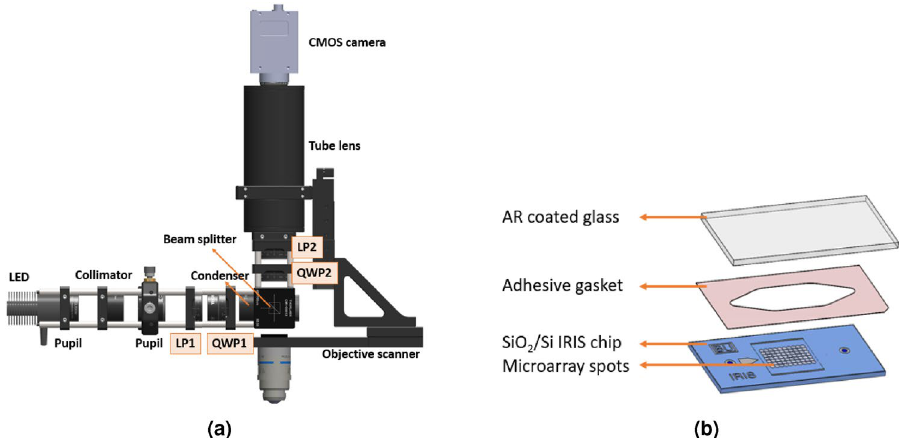
Figure 1. Optical setup of the polarization enhanced SP-IRIS ( a ) and the SP-IRIS cartridge assembly ( b ). To form the fluidic chamber, the gasket is sandwiched between the chip and the AR coated